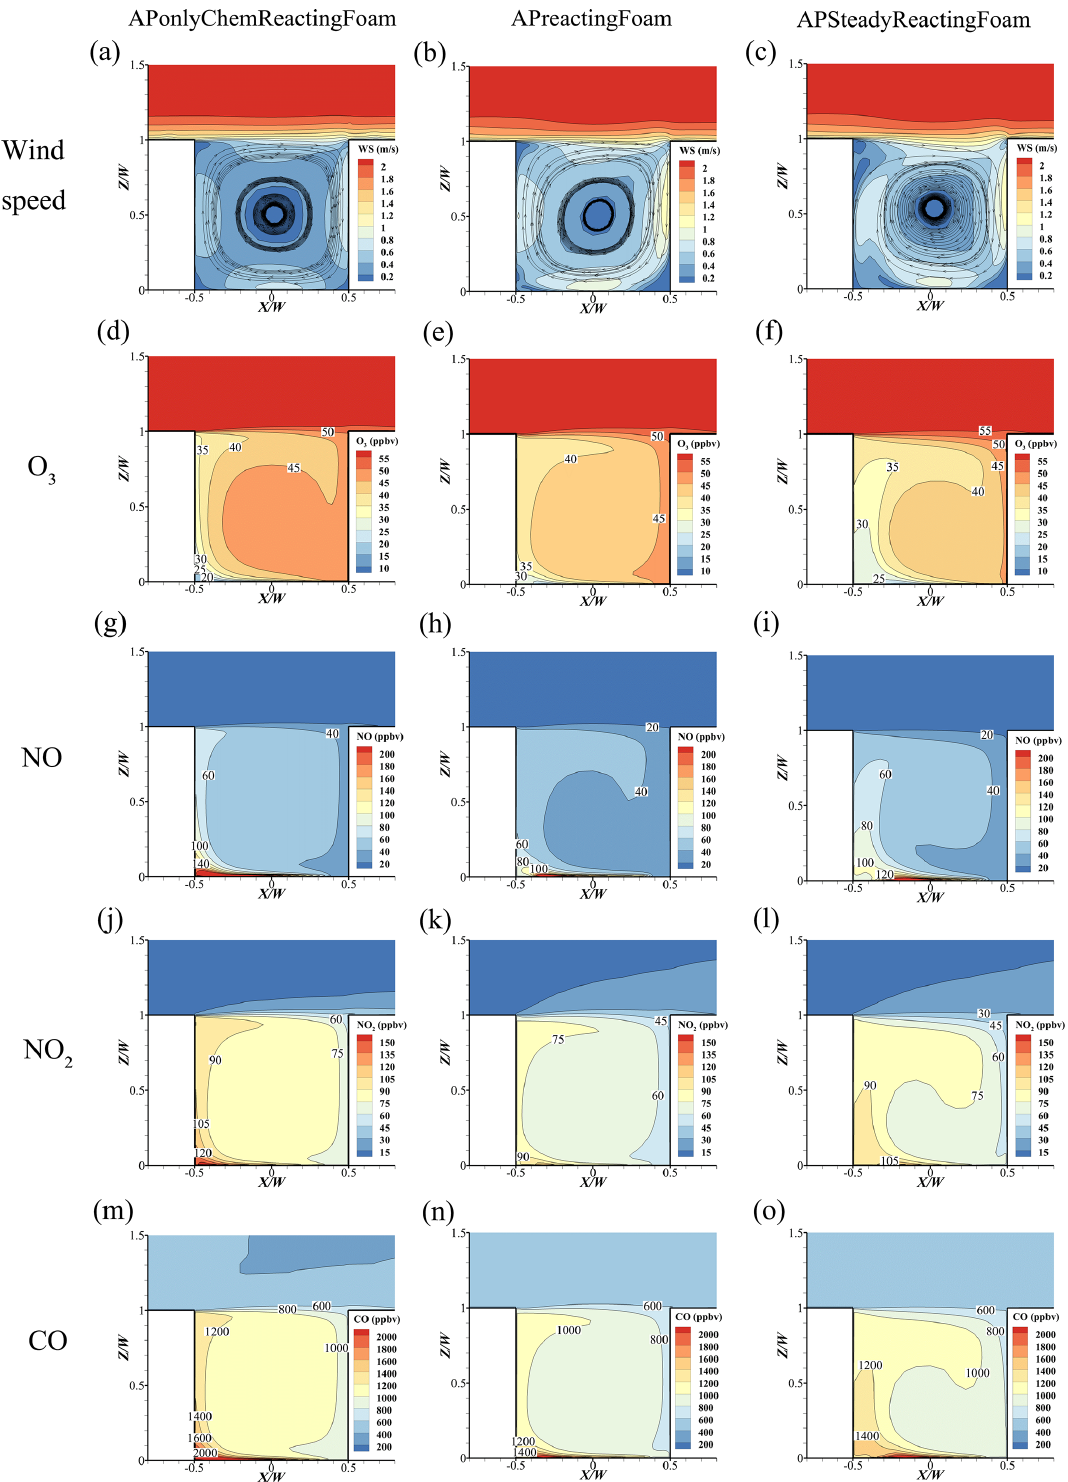
Figure 13. The comparison of (a–c) wind speed, (d–f) O 3 , (g–i) NO, (j–l) NO 2 , and (m–o) CO between APonlyChemReactingFoam, APreactingFoam, and